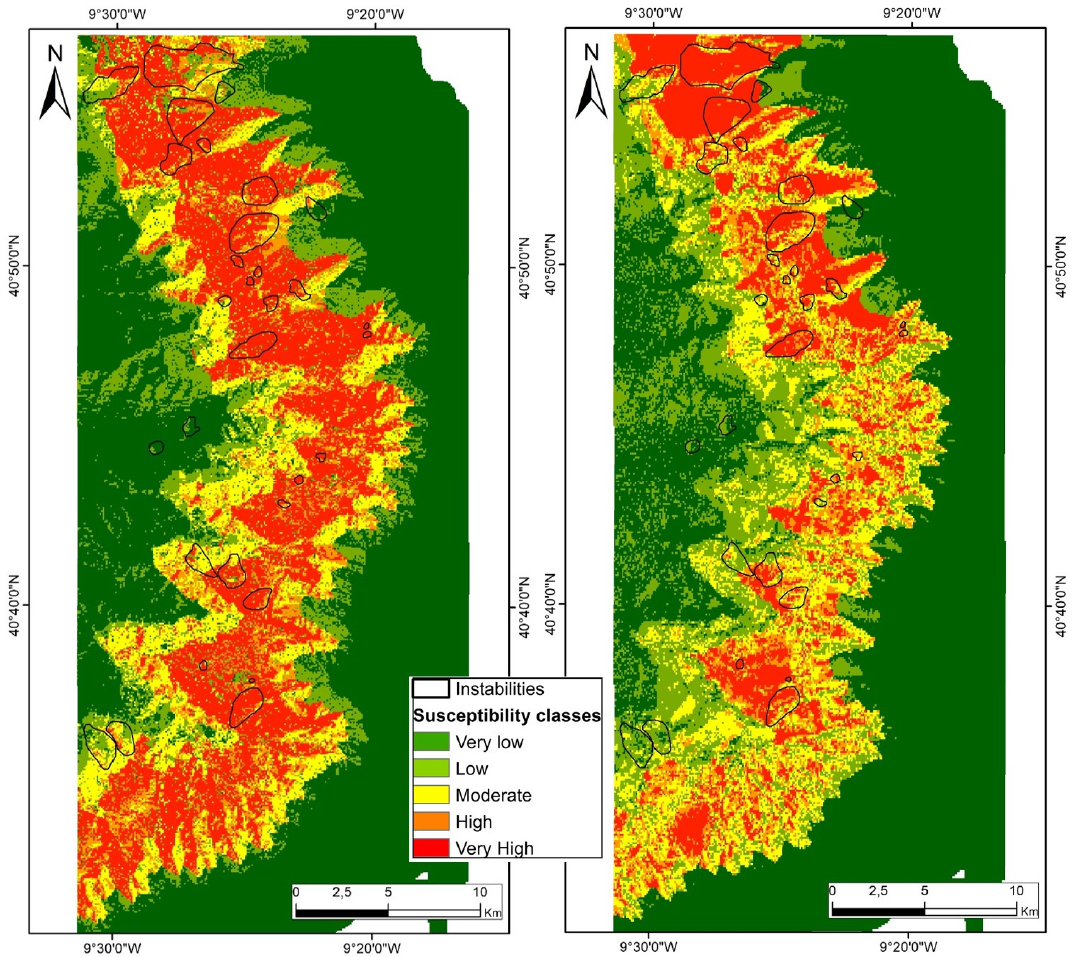
Figure 6 Figure 6. Susceptibility maps based on the information value (IV) model with all factors (on the left), and on the logistic regression (LR) model with all factors (on the right). Black polygons correspond to the delimitations of the identified